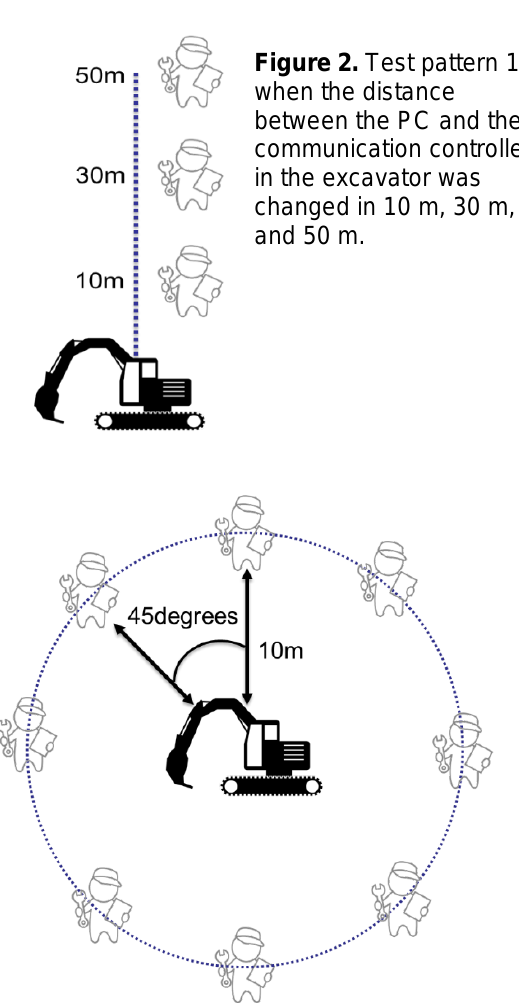
Figure 3. Test pattern 2: when the PC's position is fixed at 10 m away from the centre of the communication controller and the construction machine is rotated in increments of 45